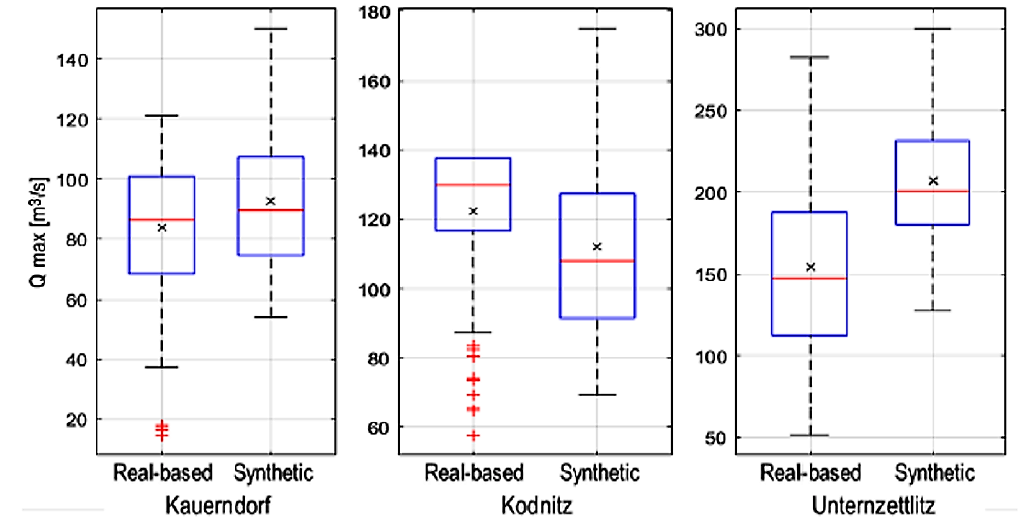
Figure 5. Comparison between the maximum flow of the three gauges for the events of the REBD and the SD.